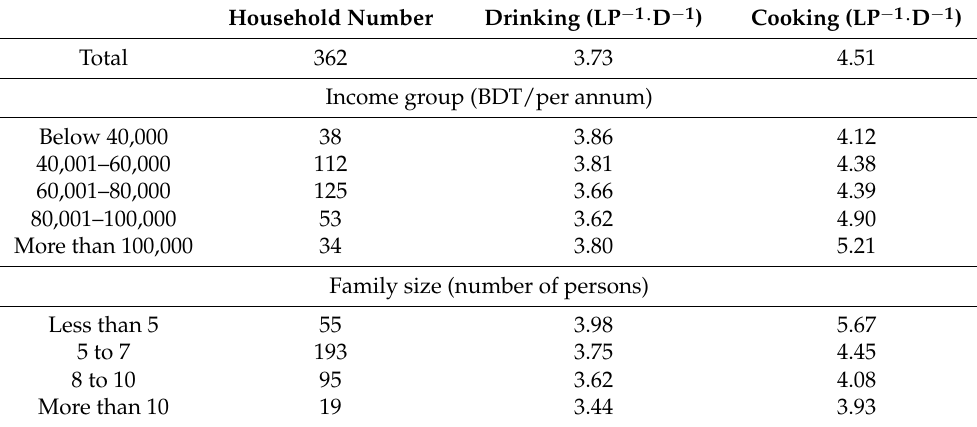
Table 3. Water consumption in the studied households of Southkhali Union.